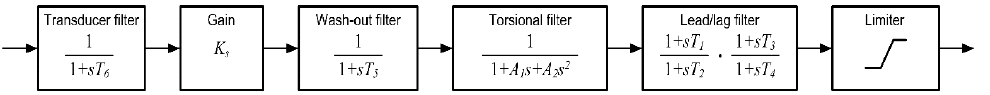
Figure 2. Type PSS1A single-input power system stabilizer. Reproduced from [39], IEEE: 2016.